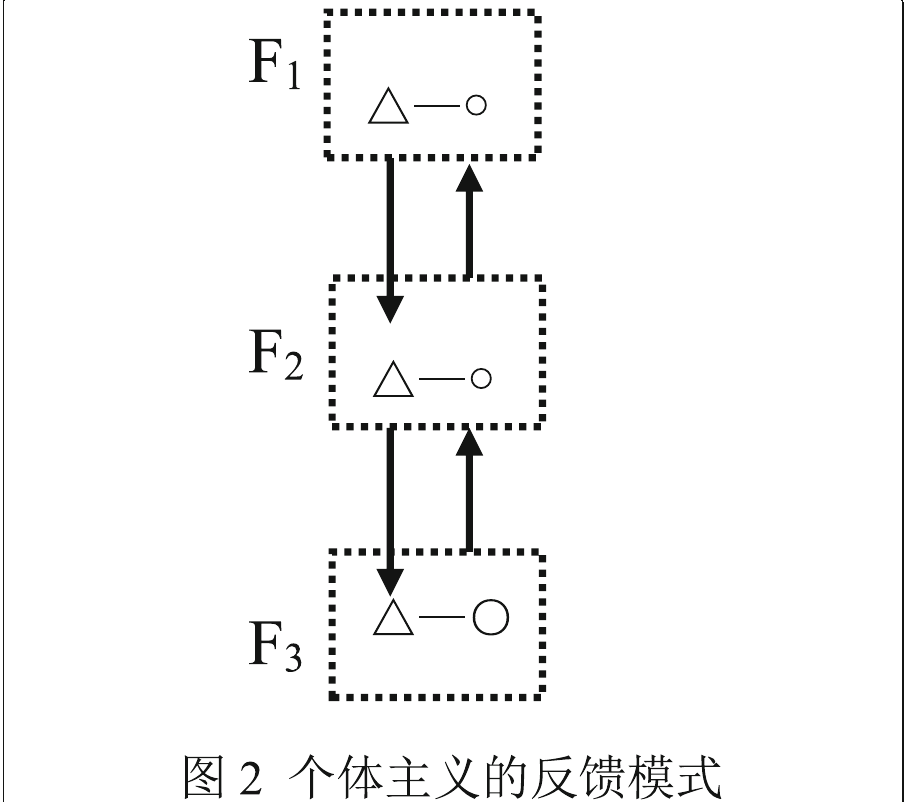
Fig. 2 The reciprocal model from individual